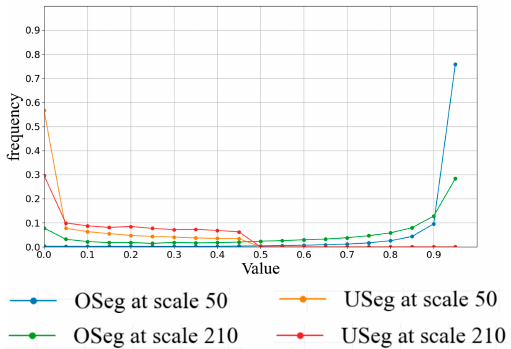
Figure 14. Frequency distributions of (cid:1841)(cid:1845)(cid:1857)(cid:1859) and (cid:1847)(cid:1845)(cid:1857)(cid:1859) at scales of 50 and 210.